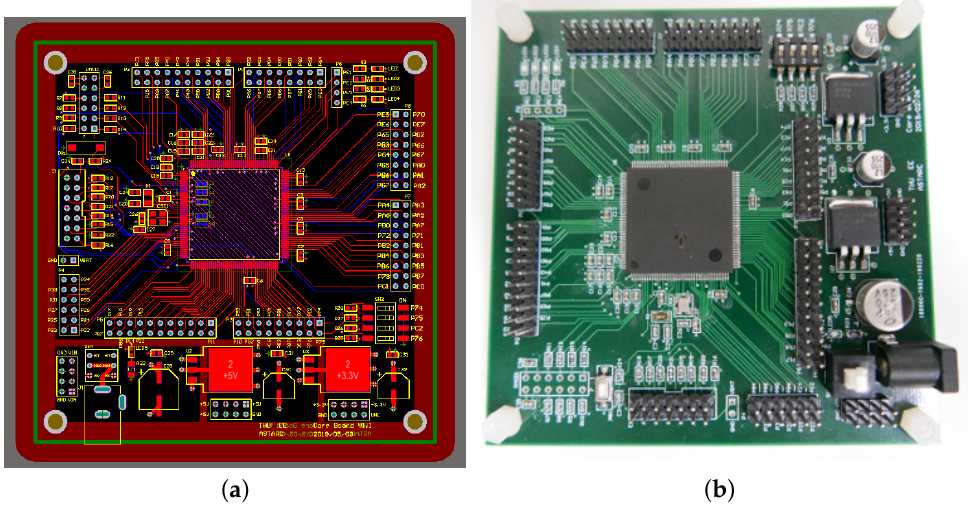
Figure 8. PCB model: ( a ) The PCB Layout Figure of repaid rapid monitoring station; ( b ) Complete diagram of all-component